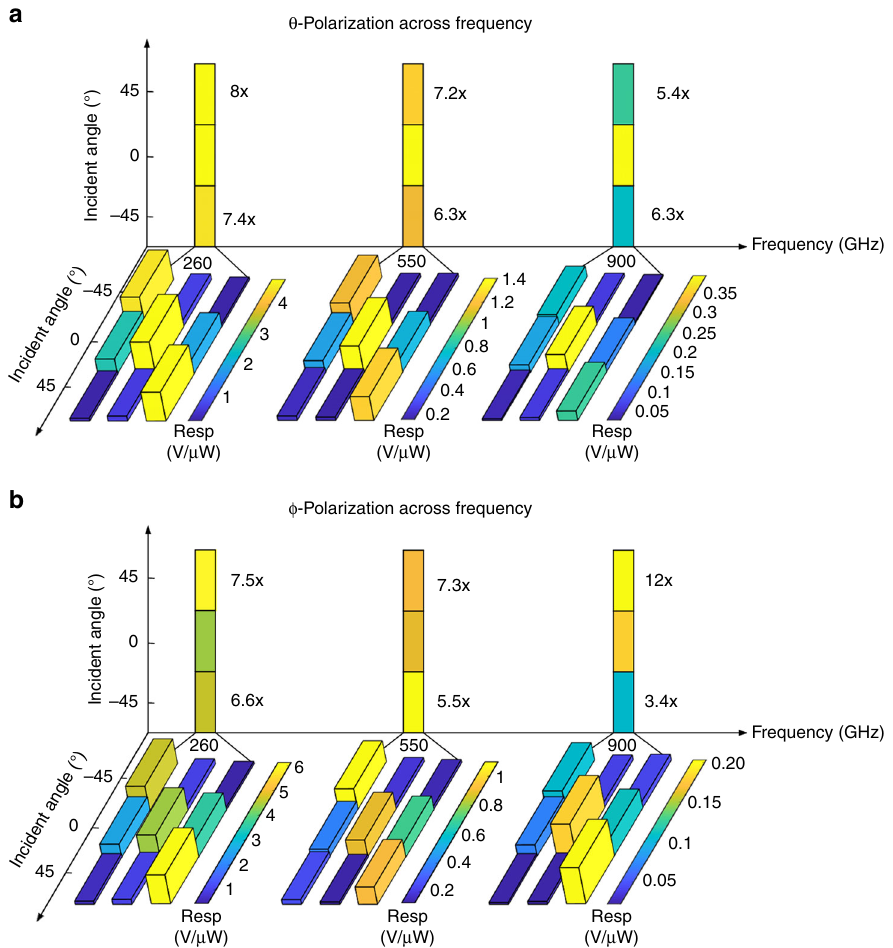
Fig. 8 Measured sensor beam programming with subwavelength recon fi guration. This is measured with varying angles of incidence for two polarizations across 0.1 – 1.0 THz. a Measured optimized performance as the incidence angle is varied for two polarizations across 0.10 – 1.0 THz. For both E θ and E φ , the sensitivity can be enhanced signi fi cantly by 5 – 12 times across 0.10 – 1.0 THz. The horizontal plane shows the instantaneous beam con fi guration when optimized for reception across the various angles of incidence (45°, 0° and − 45°). As can be seen, the reprogramming of the detector states redistributes the surface current to effectively tilt the beam toward the desired angles of incidence. The vertical plane shows the overall responsivitiy enhancement as a result of the recon fi guration when compared against the optimal normal incident state. b This is also shown in the signi fi cant enhancement with reprogramming as the polarization is switched across E θ to E φ across the